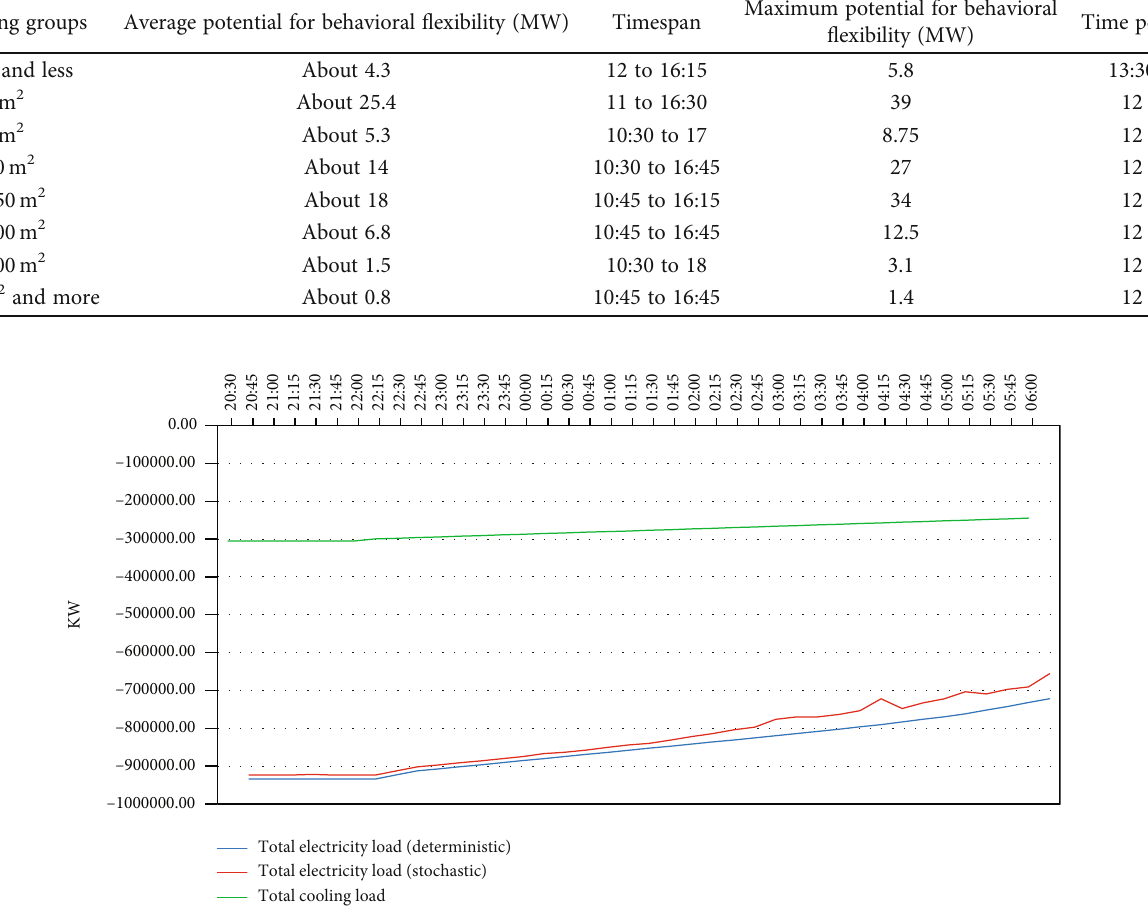
Figure 19: Basic electricity consumption and comparison of stochastic and deterministic electric load